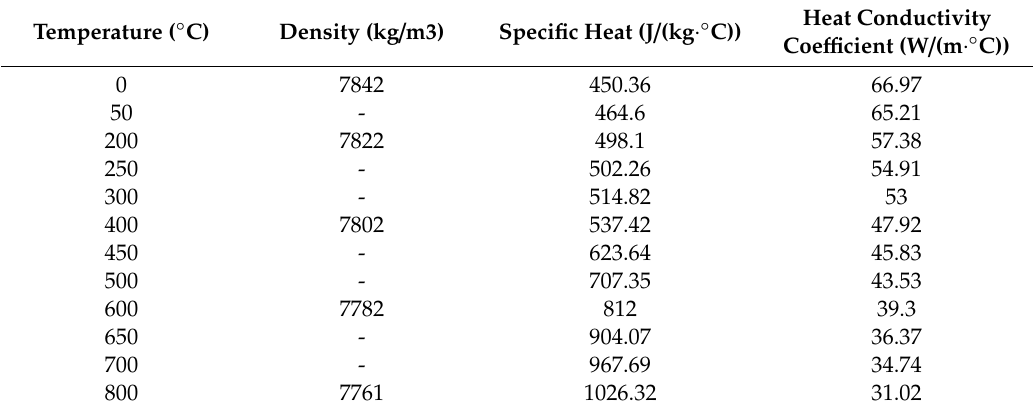
Table 1. Thermal parameters of low carbon steel.